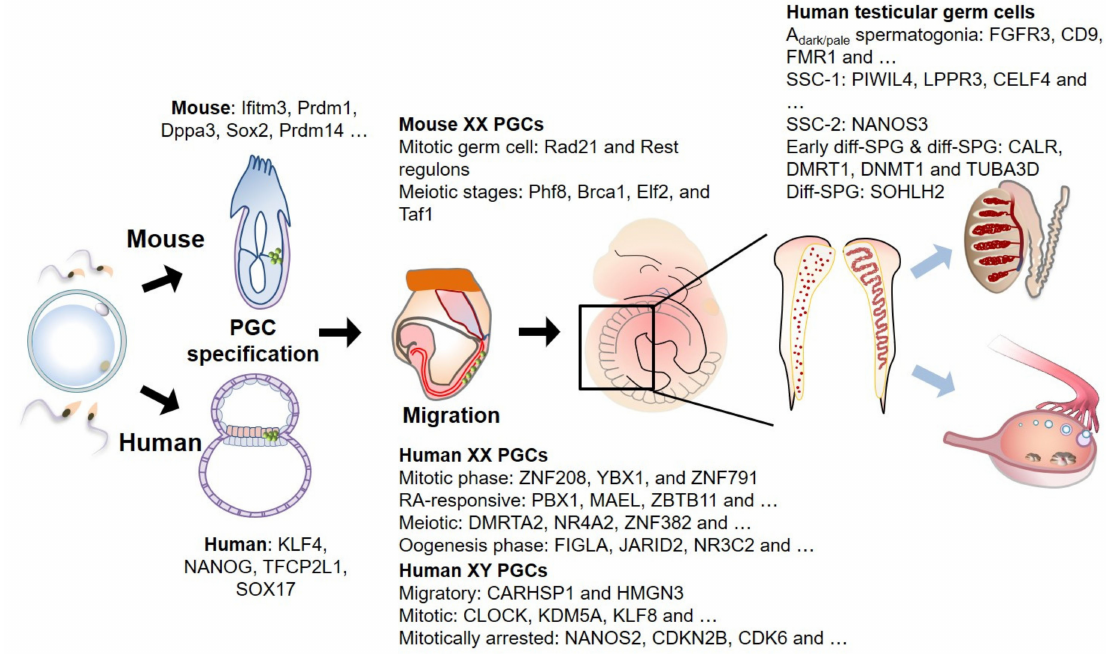
Figure 2. Human and mouse germ cell development and associated genes. Primordial germ cells (PGCs, marked as green) can be recognized for the first time at the extraembryonic region of epiblast in mouse (at ~E6.25) and a layer between epiblast and visceral endoderm in human (at ~2 to 3 weeks of gestation) during gastrulation. These cells migrate towards the genital ridge during embryo turning, and simultaneously undergo extensive epigenetic reprogramming. Upon arrival at the genital ridge, PGCs are dispersed in the female genital ridge and organized to make a winding tubular pattern in male genital ridge. Multiple scRNA-seq studies in various stages of germ cell development were performed to elucidate cellular diversity, and critical gene expression signatures in developing germ cells, terminating mitosis and entering meiosis. Stage-specific genes identified by scRNA-seq are noted. SSC: spermatogenic stem cells, diff-SPG: differentiating